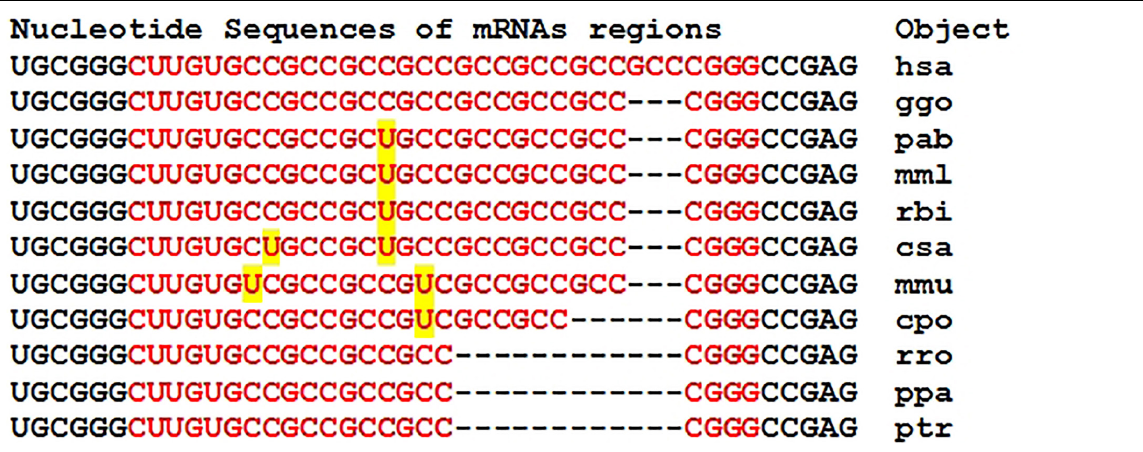
FIGURE 1 | Nucleotide sequences of 5 (cid:48) UTR regions of mRNAs of orthologous GSK3B genes containing clusters of miRNAs binding sites.